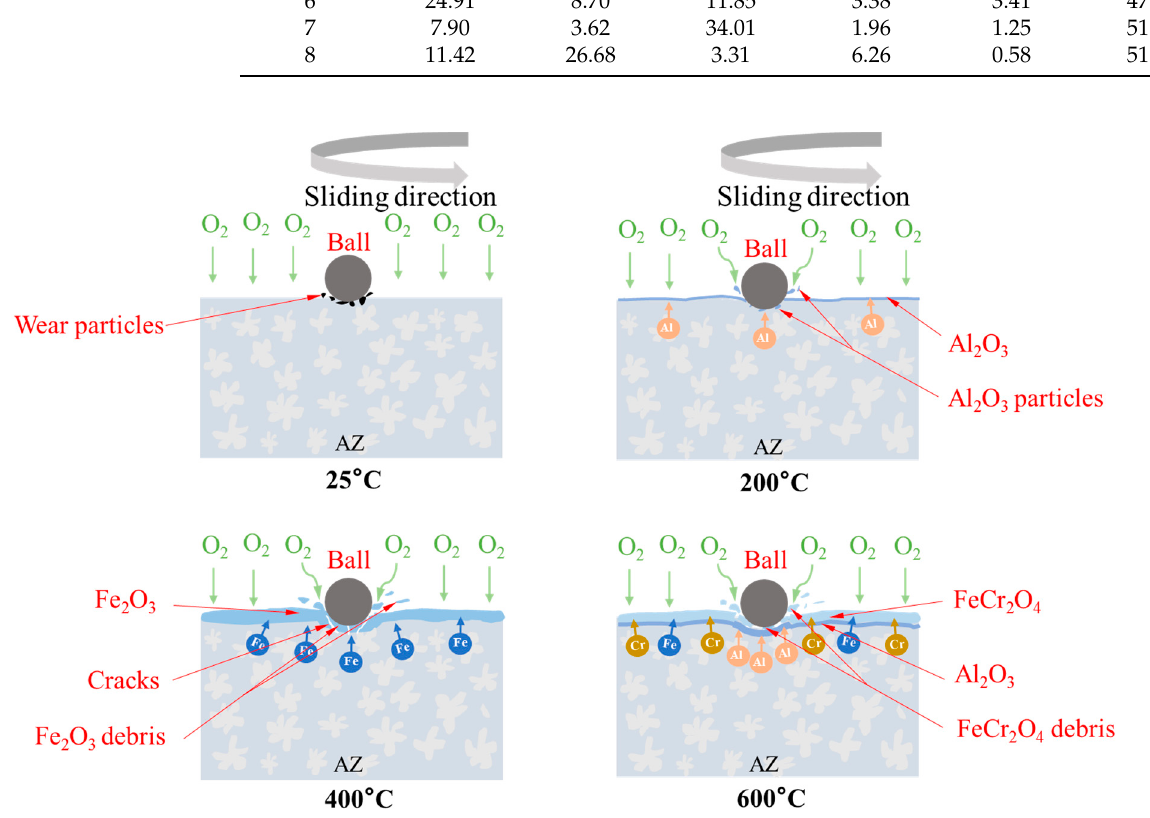
Figure 7. AZ wear mechanism at different temperatures.